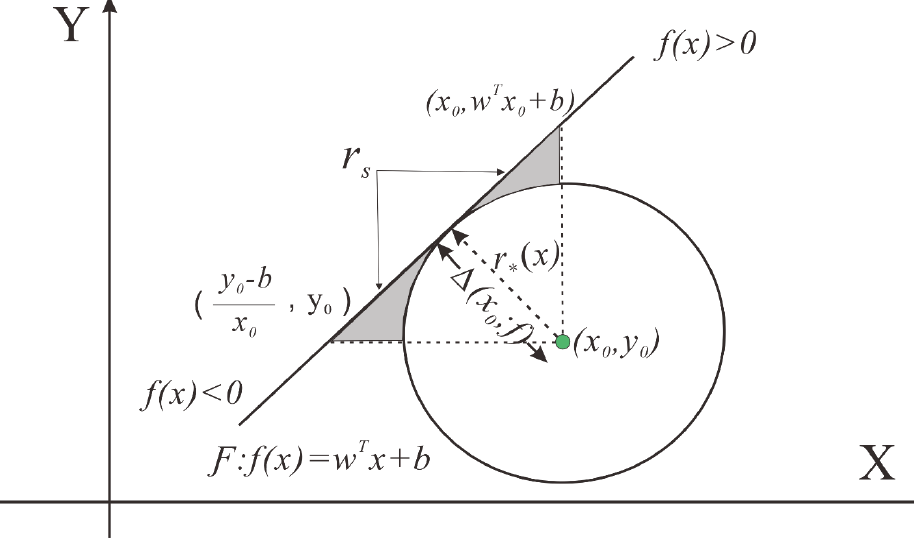
Figure 2. Calculation about shadow part 𝑟 𝑠 in PNDF for a binary classifier.